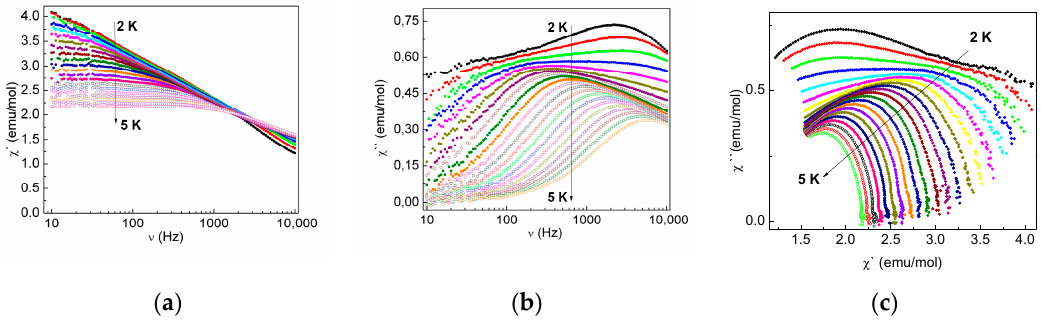
Figure 9. The frequency dependence of ac magnetic susceptibility χ ′ ( ν ) ( a ) and χ ′′ ( ν ) ( b ) under a magnetic field H = 800 Oe and the Cole–Cole diagram at different temperatures for 1-Dy ( c ).